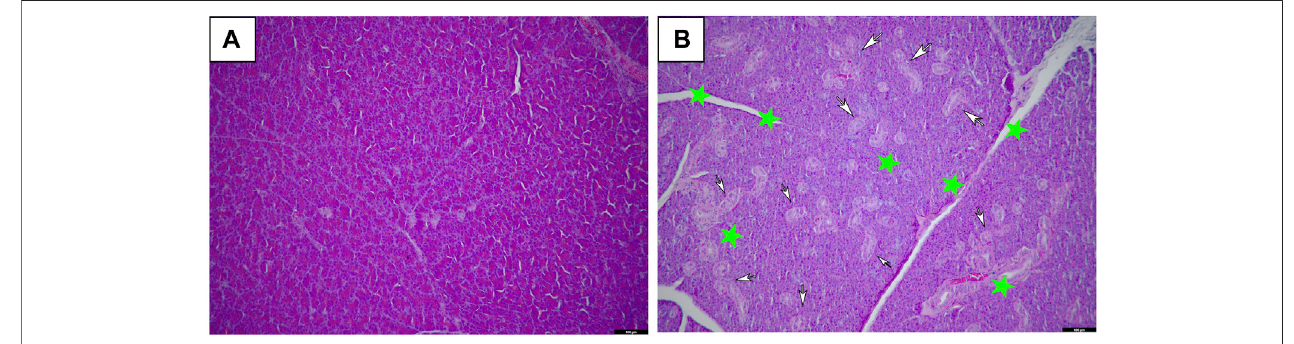
FIGURE3| HistopathologicalchangesoffemaleSDratsinthe28-dayoraladministrationtoxicitytest. (A) Normalmicroscopicstructureofthepancreasofafemale SD rat (x100). (B) Acinar cell atrophy (star) and ductular hyperplasia (arrows) inthe pancreas of afemale SD ratadministered1,000 mg/kg ofBromochlorophene (x100).